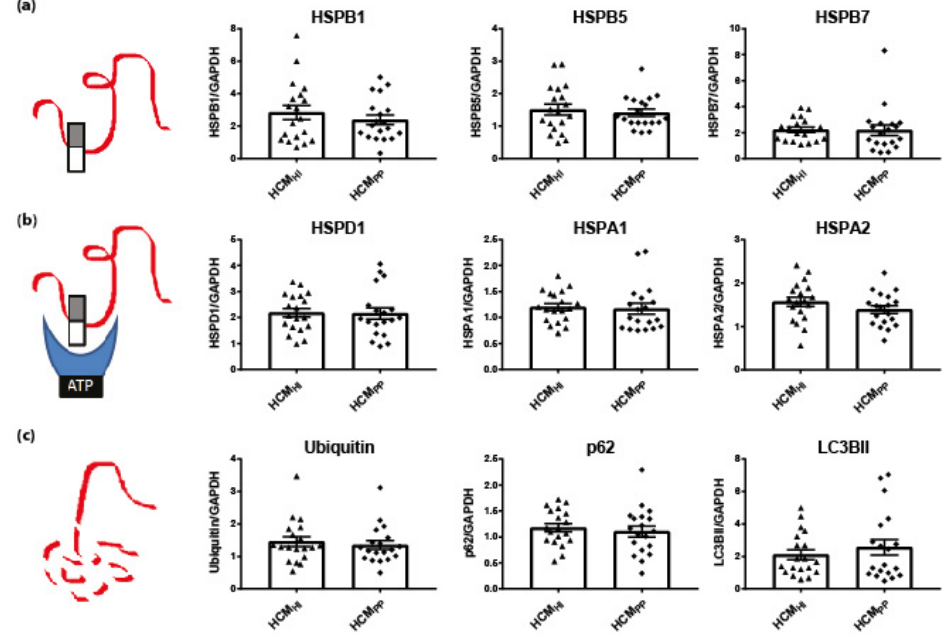
Figure 5. Pathomechanism of HCM and key PQC players. ( a ) Stabilizing HSPs (HSPB1, HSPB5, HSPB7), ( b ) HSPs with refolding capacity (HSPD1, HSPA1 HSPA2) and ( c ) degradation markers (ubiquitin, p62, LC3BII) were not significantly di ff erent between HCM HI ( n = 19) and HCM PP ( n = 19). Each dot in